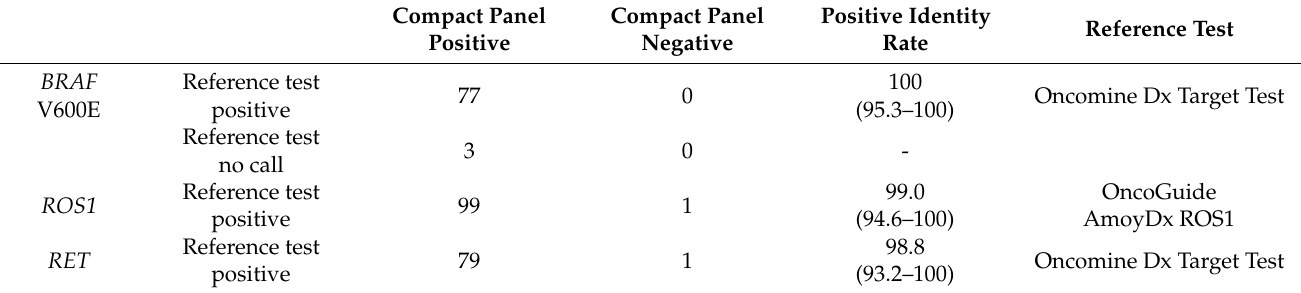
Table 4. Concordance of the compact panel with approved diagnostic tests using artificial samples. Parentheses in identity rates indicate a 95% confidence